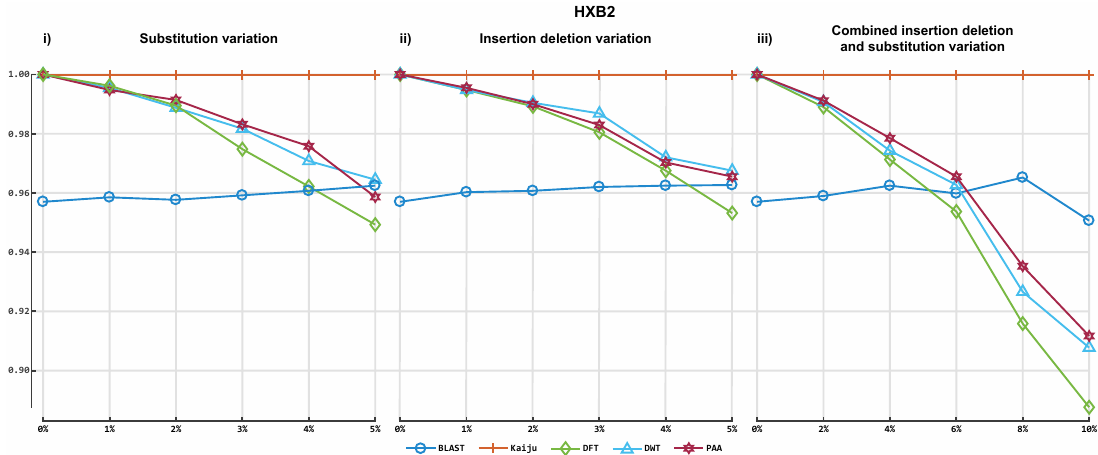
Figure 3. Accuracy of our prototype classification implementation and two established tools on HIV-1 HXB2 simulated datasets. All plots illustrate the F -measures obtained on the 16 different HIV datasets. The y-axis indicates the F -measure score, and the x-axis depicts the reads data files. Plot 3-i depicts the F -measures obtained for each classifier on the simulations with 0% to 5% of substitution variation rate. Plot 3-ii illustrates the F -measures obtained for each classifier on the simulations with 0% to 5% uniform insertion/deletion variation, and plot 3-iii illustrates the F -measures obtained for each tool on simulations of uniform 0% to 10% insertion/deletion and substitution variation.